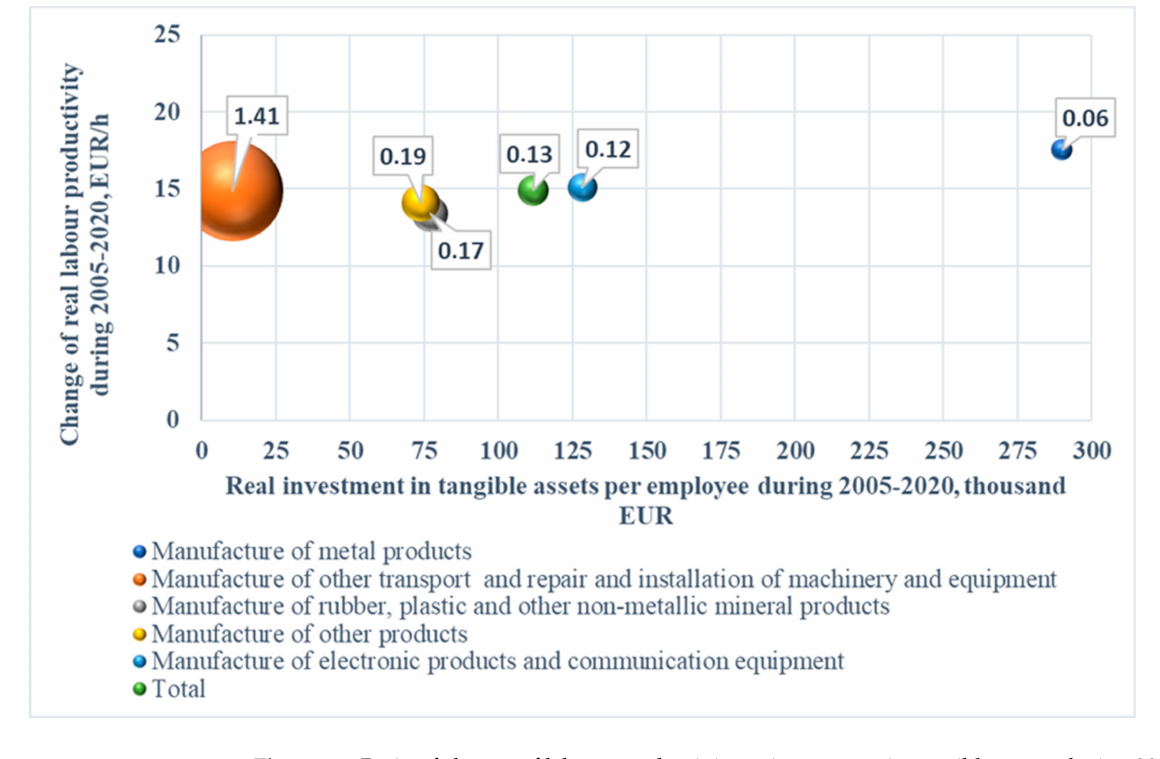
Figure 10. Ratio of change of labour productivity to investment in tangible assets during 2005–2020 (own estimation).